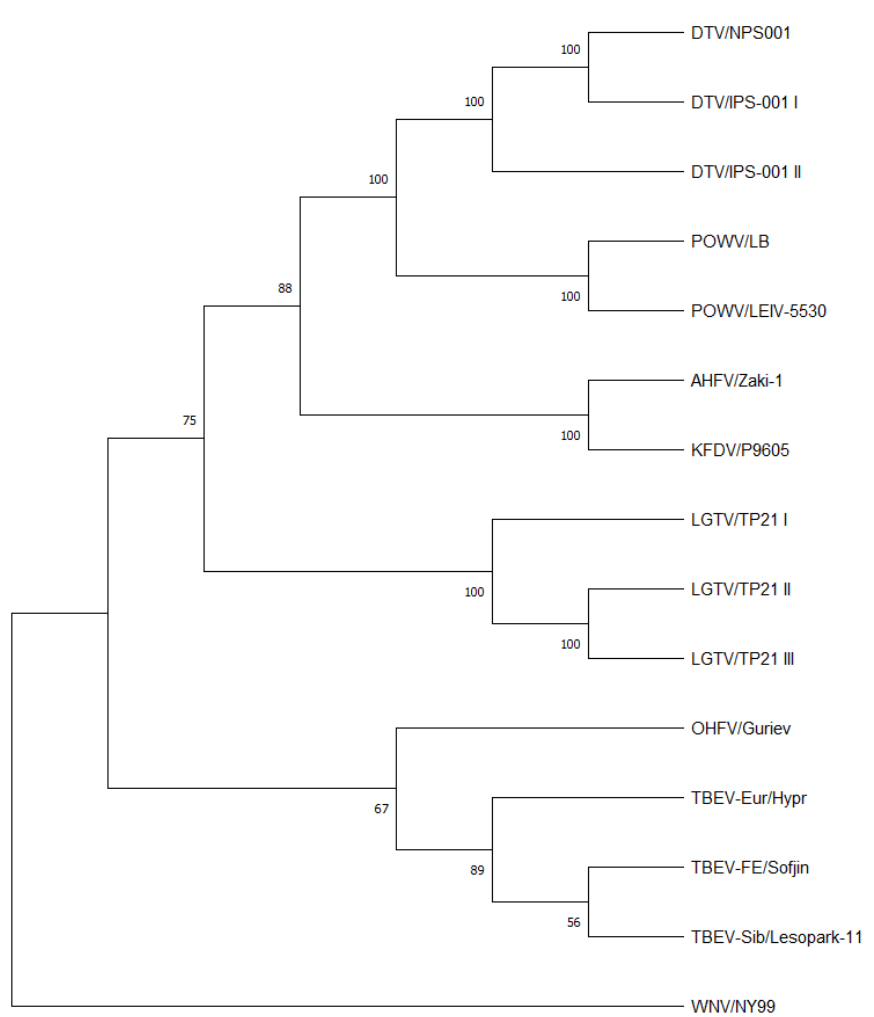
Figure 1. Phylogenetic analysis of the coding regions of listed viruses. The neighbor-joining tree was constructed using the Jukes-Cantor algorithm in MEGA 11.0.13. The numbers on the tree represent bootstrap values from 500 replications. Note all viral sequences were derived in this and previous studies except for TBEV-Sib Lesopark 11, which was taken from Genbank.